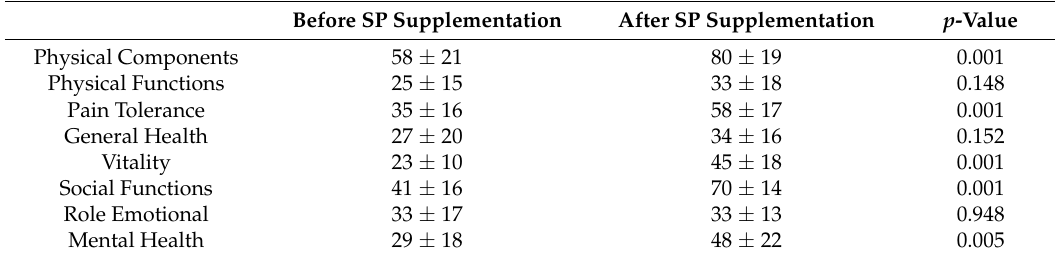
Table 4. Evaluation of the quality of life assessed by the short form 36 (SF-36)